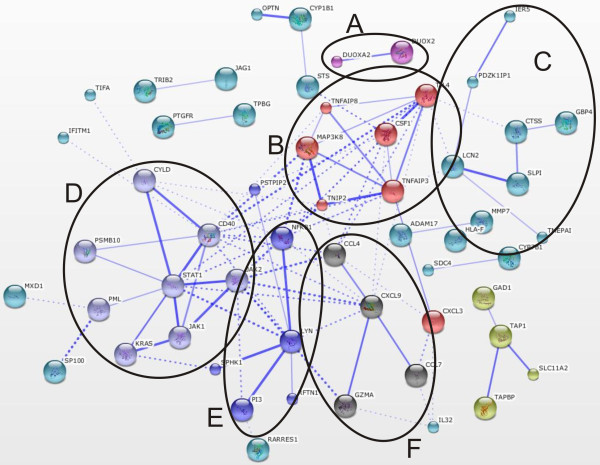
The gene functional clusters identified for the significant, upregulated liver tissue transcriptome. The liver tissue upregulated network (n = 5) consisted of 6 clusters: (A) ROS production; (B) innate immune system; (C) extracellular matrix remodelling; (D) JAK-STAT signaling; (E) NFκB signaling; (F) chemo-attraction of T- and NK-cells.